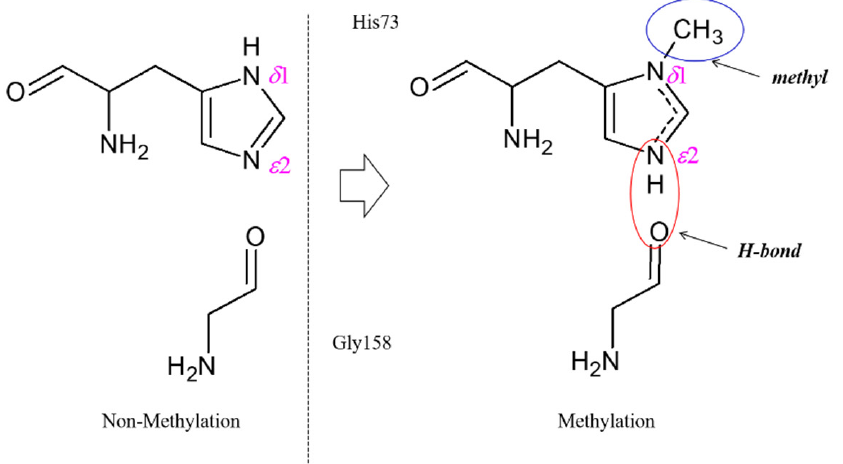
Figure 4. The interaction between His73 and Gly158 could be enhanced by the formation of an H-bond when His73 experiences side chain methylation.